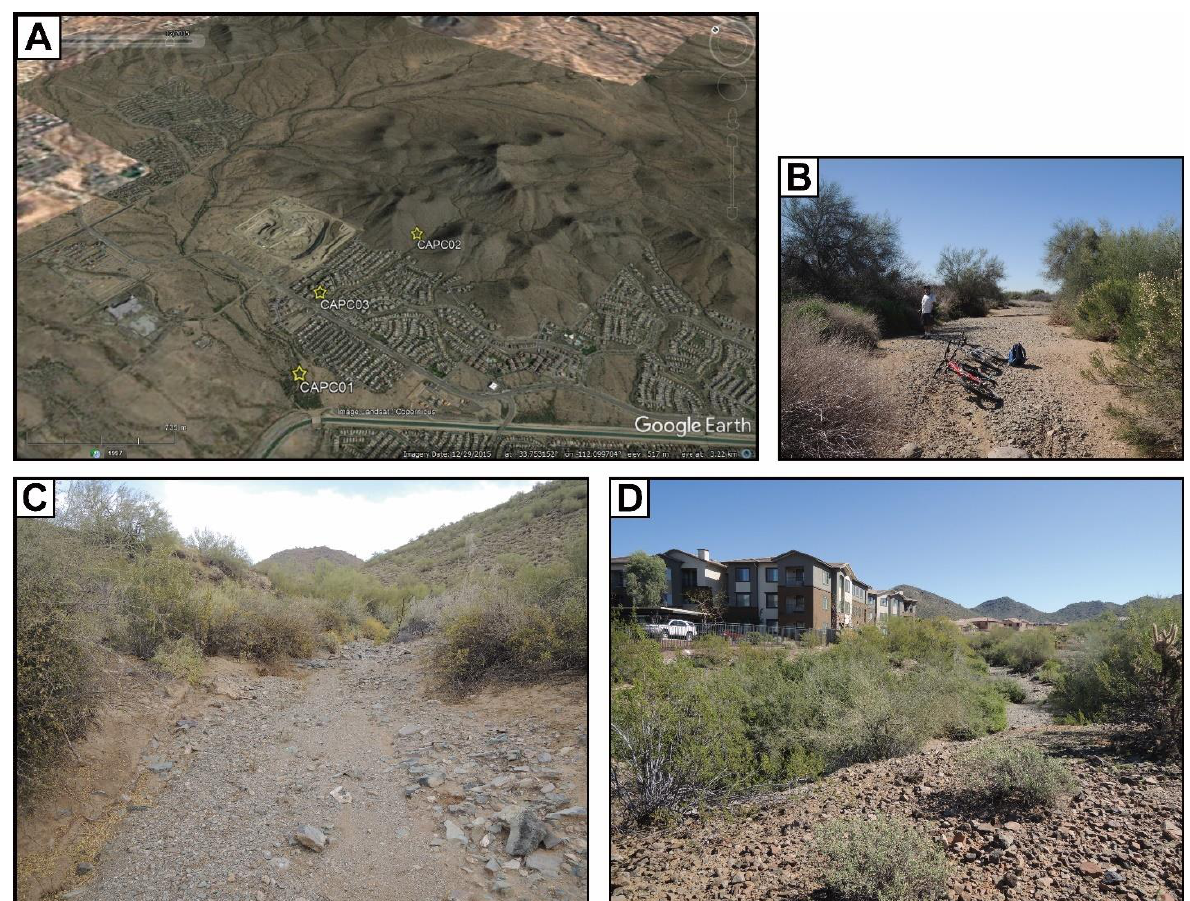
Figure 5. Study sites of the experiment to assess if the CADR is impacted by urbanization. ( A ) Google Earth view showing sampling locations and different land uses in the controlled experiment catchment. ( B ) Sampling location of the CAPC01 sample. ( C ) Sampling location of the CAPC02 sample. The CAPC02 subcatchment is within the Sonoran Preserve. ( D ) Sampling location of the CAPC03 sample, where the land surrounding CAPC03 was either recently built homes or bare ground.